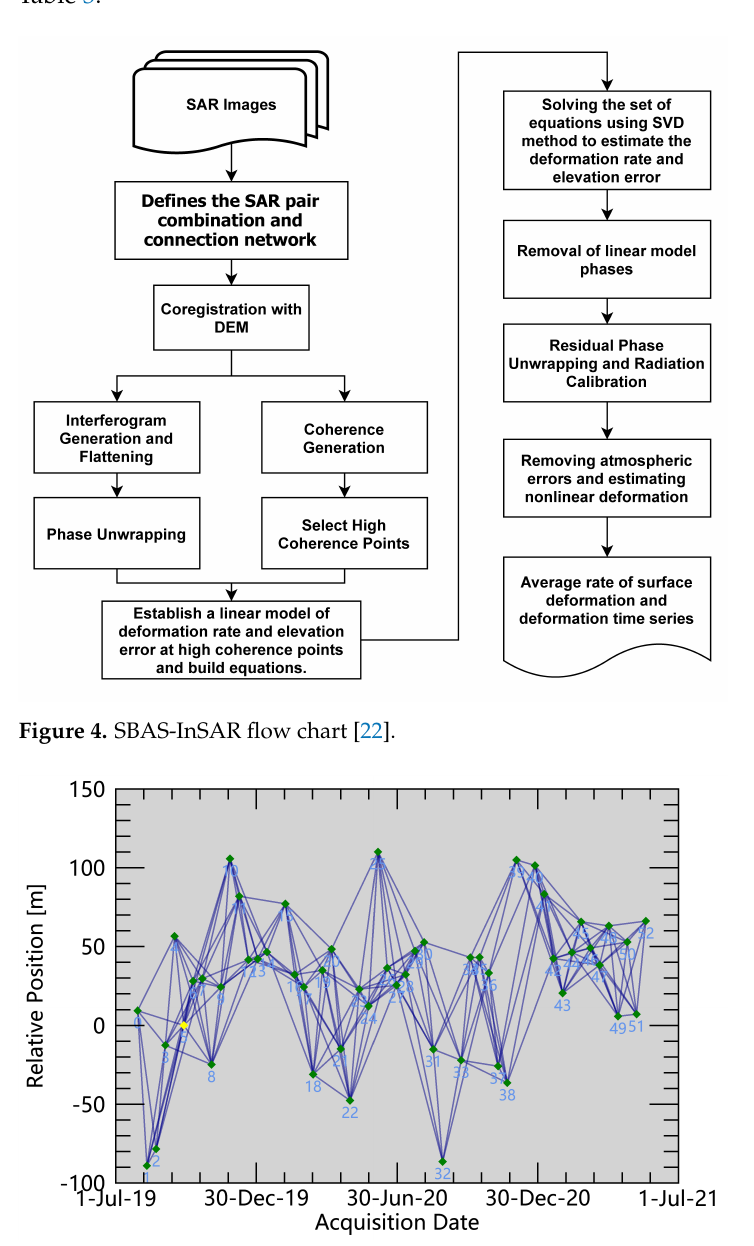
Figure 5. Connection diagram of spatio-temporal baseline. The yellow point represents the super master